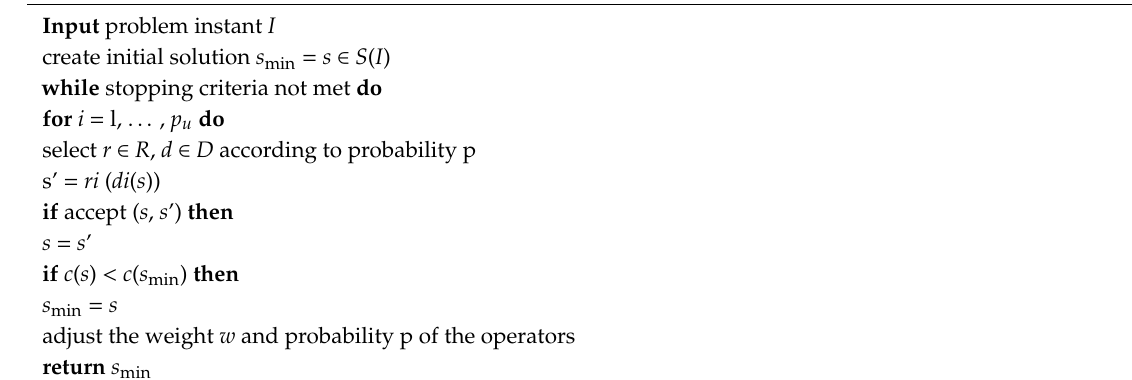
Algorithm 1 . Adaptive Large Neighborhood Search (ALNS)